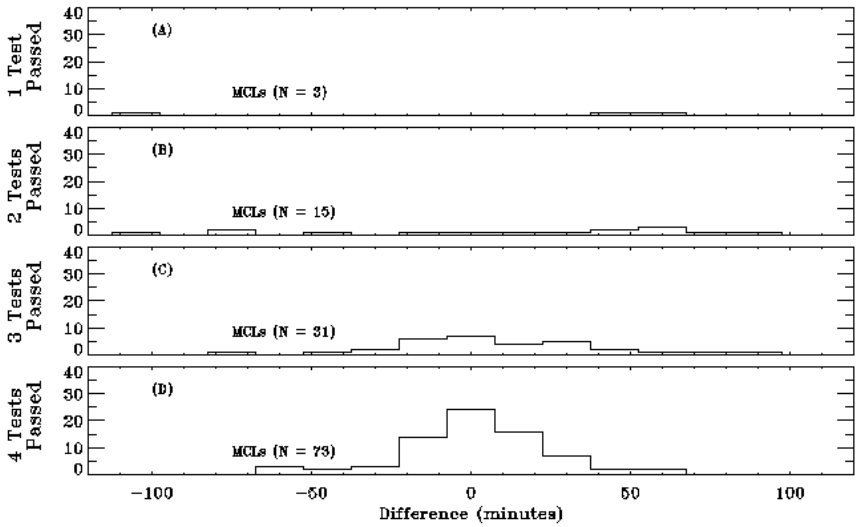
Fig. 5. Histograms of 1t 0 =[ t B *(test)– t B (auto)], similar to those shown in Fig. 4, but now for the number of N (total)=122 MCLs of Data Set #2 that passed a given number of tests, up to the full number of four, for the 5min averages. For example, Fig. 2b reveals that 15 events passed two tests, and (B) here shows the 15 specific 1t 0 ’s that were associated with those 15 cases. Likewise, Fig. 2b reveals that 17